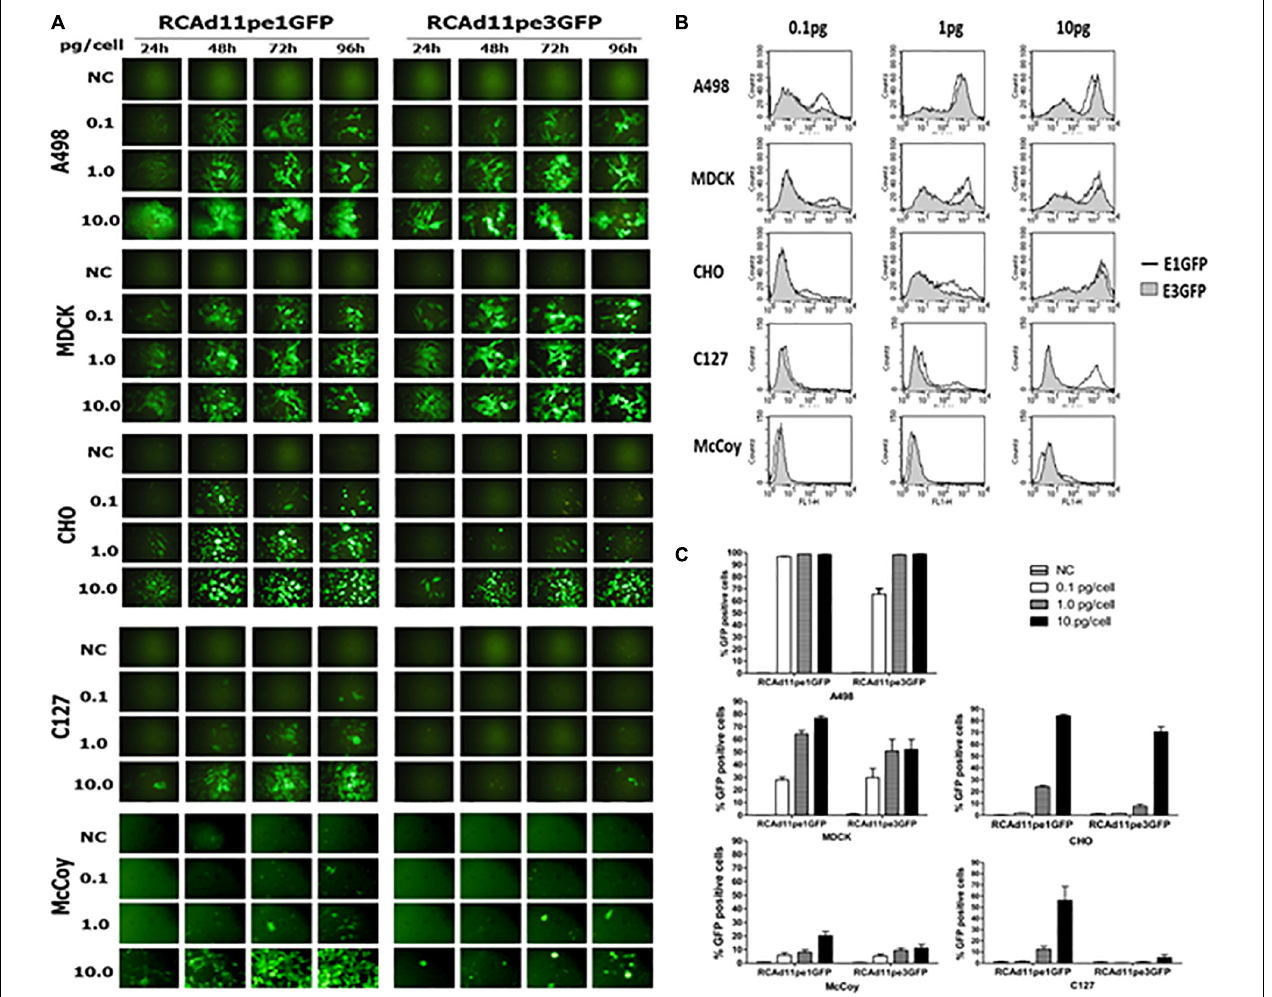
FIGURE 3 | The abilities of the RCAd11pe1GFP and RCAd11pe3GFP viruses to infect human, dog, hamster, and mouse cells are compared. (A) Cells were infected with various amounts of RCAd11pe1 or RCAd11pe3 vectors and incubated for 24, 48, 72, or 96 h. GFP expression was assayed daily in each cell line using fluorescence microscopy. Images obtained using fluorescence microscopy at 200 × magnification. (B) The percentage of GFP-expressing cells with 0.1, 1, and 10 pg virus/cell was assessed using flow cytometry at 48 h.p.i. Results are from at least three independent experiments. (C) Comparison of GFP expression mediated by RCAd11pe1 or RCAd11pe3 vector, as shown by the histogram overlay. Open profile indicates RCAd11pe1GFP whereas the shaded profile represents RCAd11pe3GFP.